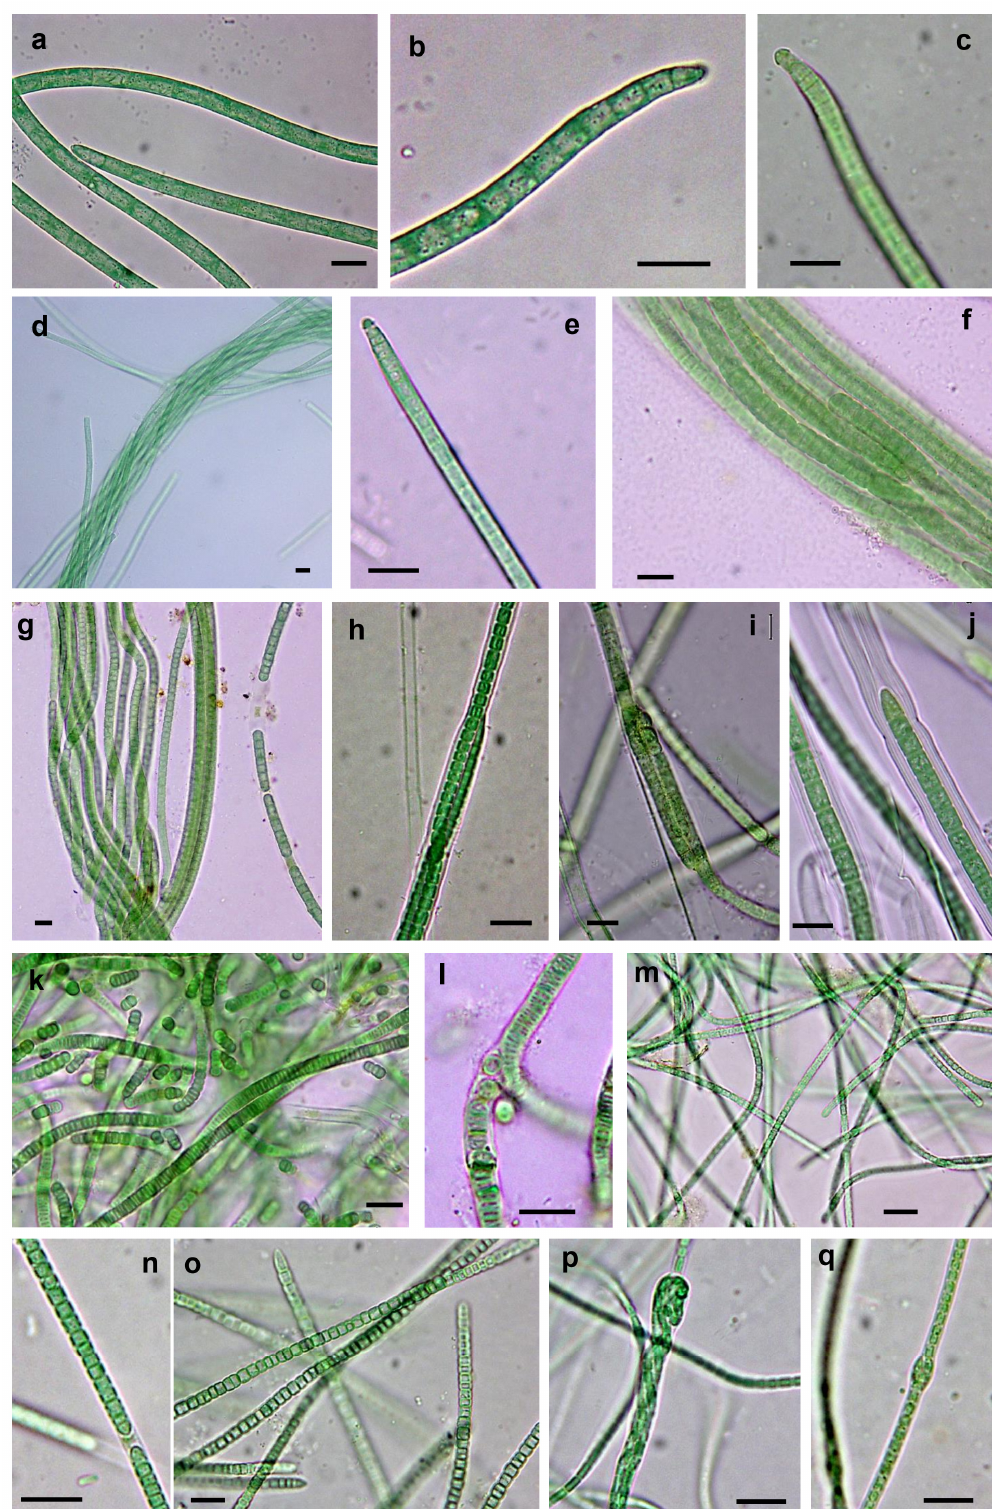
Figure 4. Microphotographs of non-heterocystous cyanobacterial strains. ( a , b ) Microcoleus vaginatus LSB45, ( c ) M. vaginatus LSB11, ( d , e ) Microcoleus sp. LSB13, ( f , g ) Trichocoleus sociatus LSB101, ( h ) Microcoleus steenstrupii SBC72, ( i ) M. steenstrupii LSB116, ( j ) M. steenstrupii LSB112, ( k ) and (l) Pseudophormidium sp. SIK74 ( m , n ) Trichocoleus desertorum SBC54, ( o ) T. desertorum LSB90, ( p ) Nodosilinea sp. SBC126, ( q ) Nodosilinea sp. LSB127. Scale bar 10 µ